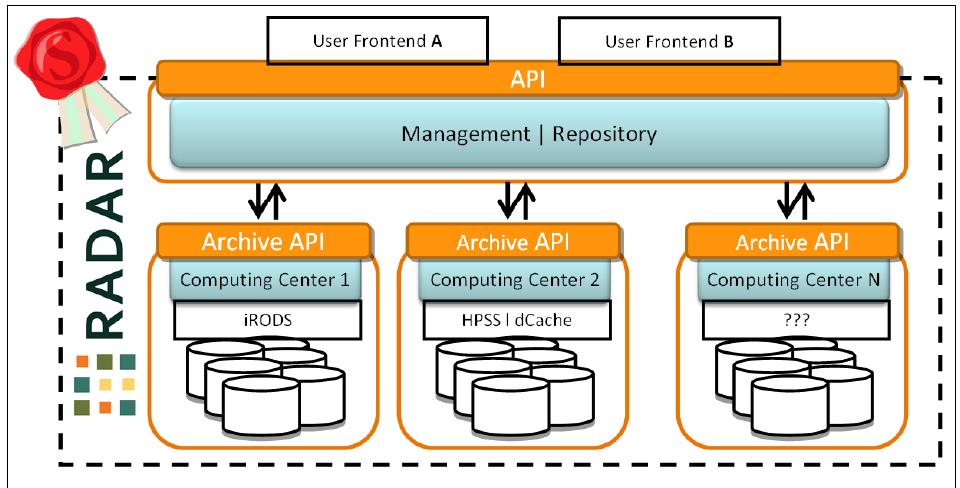
Figure 1. Scheme of the RADAR—Research Data Repository—architecture that shows the API